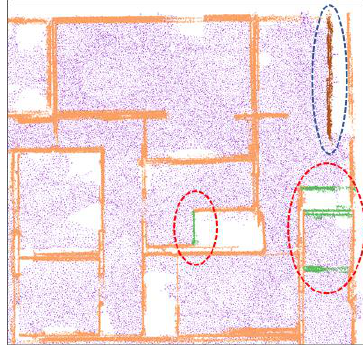
Figure 2: The figure shows the top view of several rooms. Detected walls are in orange, and the red circles show the missing walls, which after visual inspection, their label changed to the wall. The blue circle shows a false positive wall, which should be classified as a